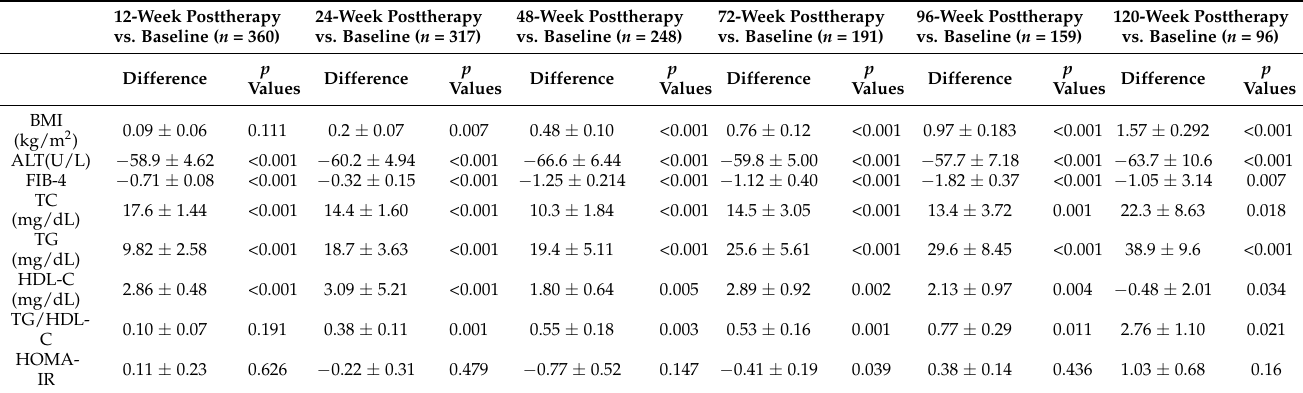
Table 3. Comparisons of various profile values between different time points of the same SVR